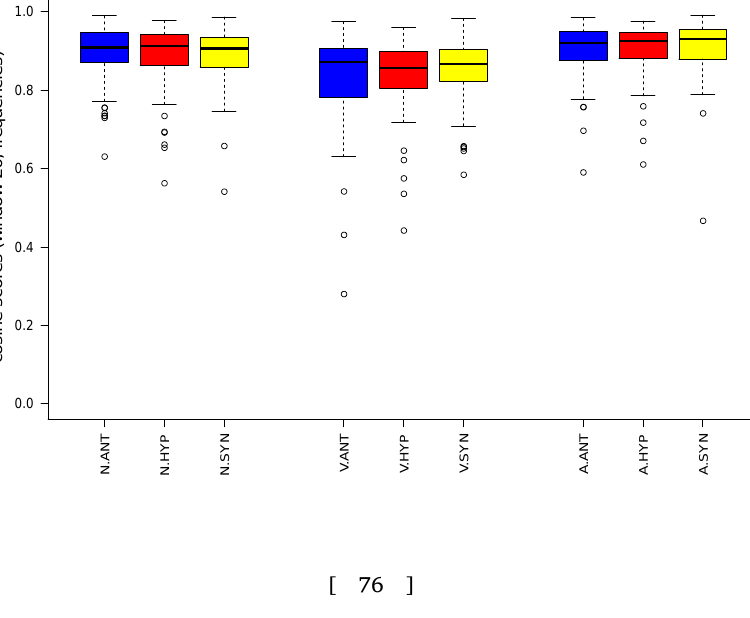
Boxplots of cosine scores across classes and relations (window 20, frequencies